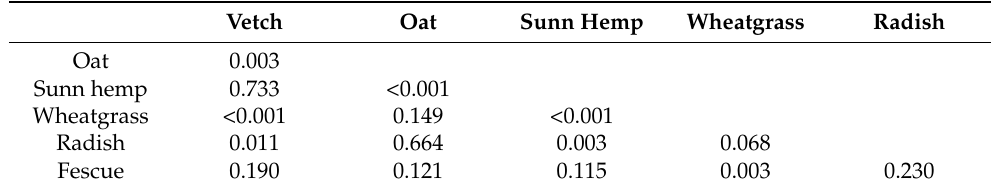
Table 1. p -values for the pairwise comparisons using log-rank test between seed types for the seed preference study ( n = 6770 total seeds).